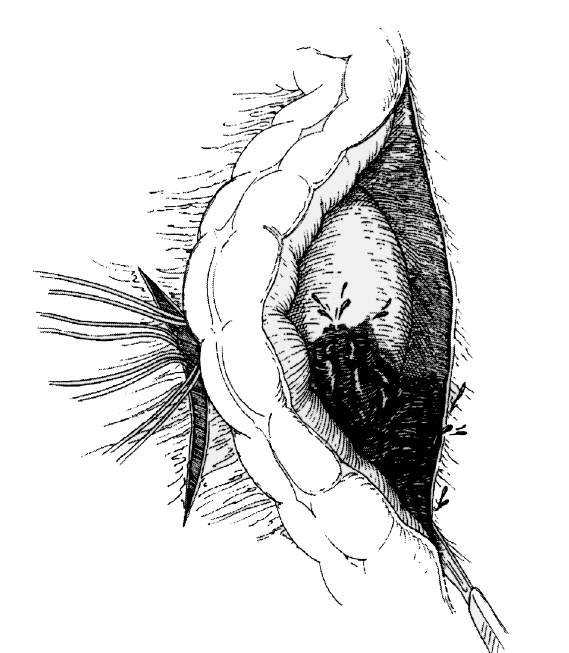
Figure 4 - The retroperitoneal incision lateral to the colon, exposing the kidney. (Reprinted with permission from: McAninch JW: Surgery for Renal Trauma. In: Novick AC, Streem SB, Pontes JE (eds.), Stewart’s Operative Urology. Baltimore, Williams & Wilkins. 1989; 234-9).